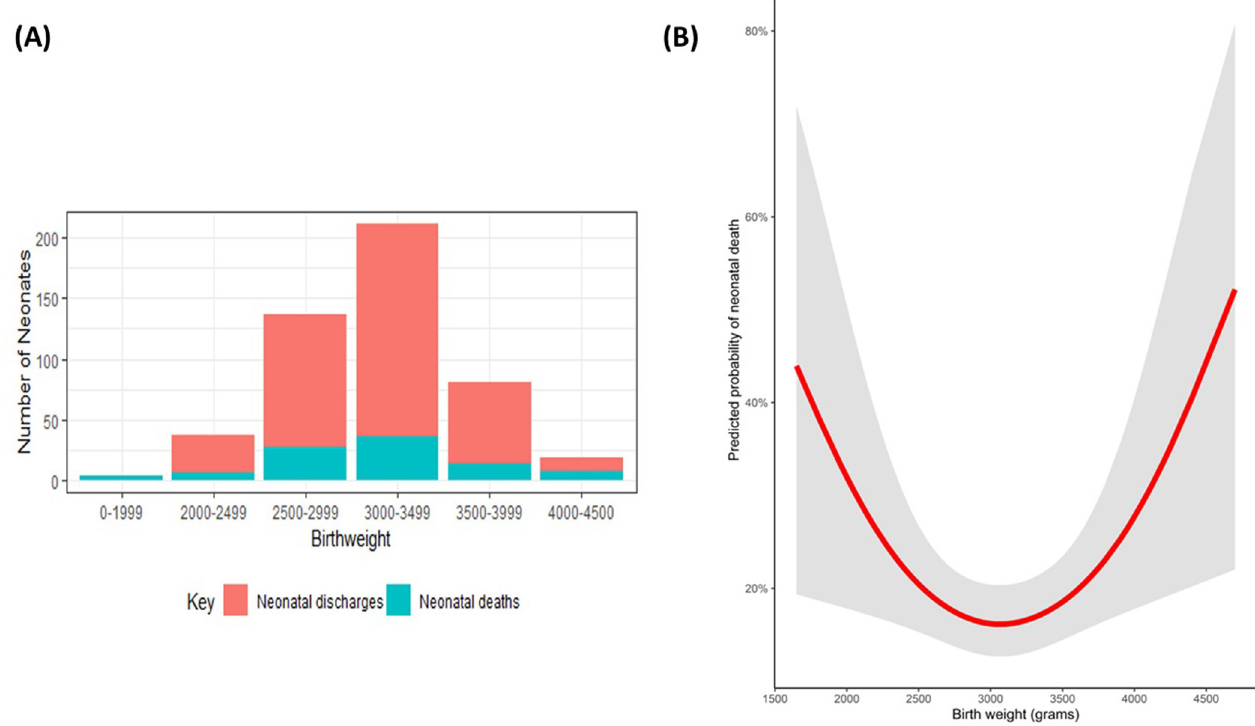
Fig 1. (A) Range of Birthweights of neonates with NE over the 12-month period; (B) Predicted probabilities of NND as a smooth function of birthweight (red) with 95% prediction limits (shaded area).